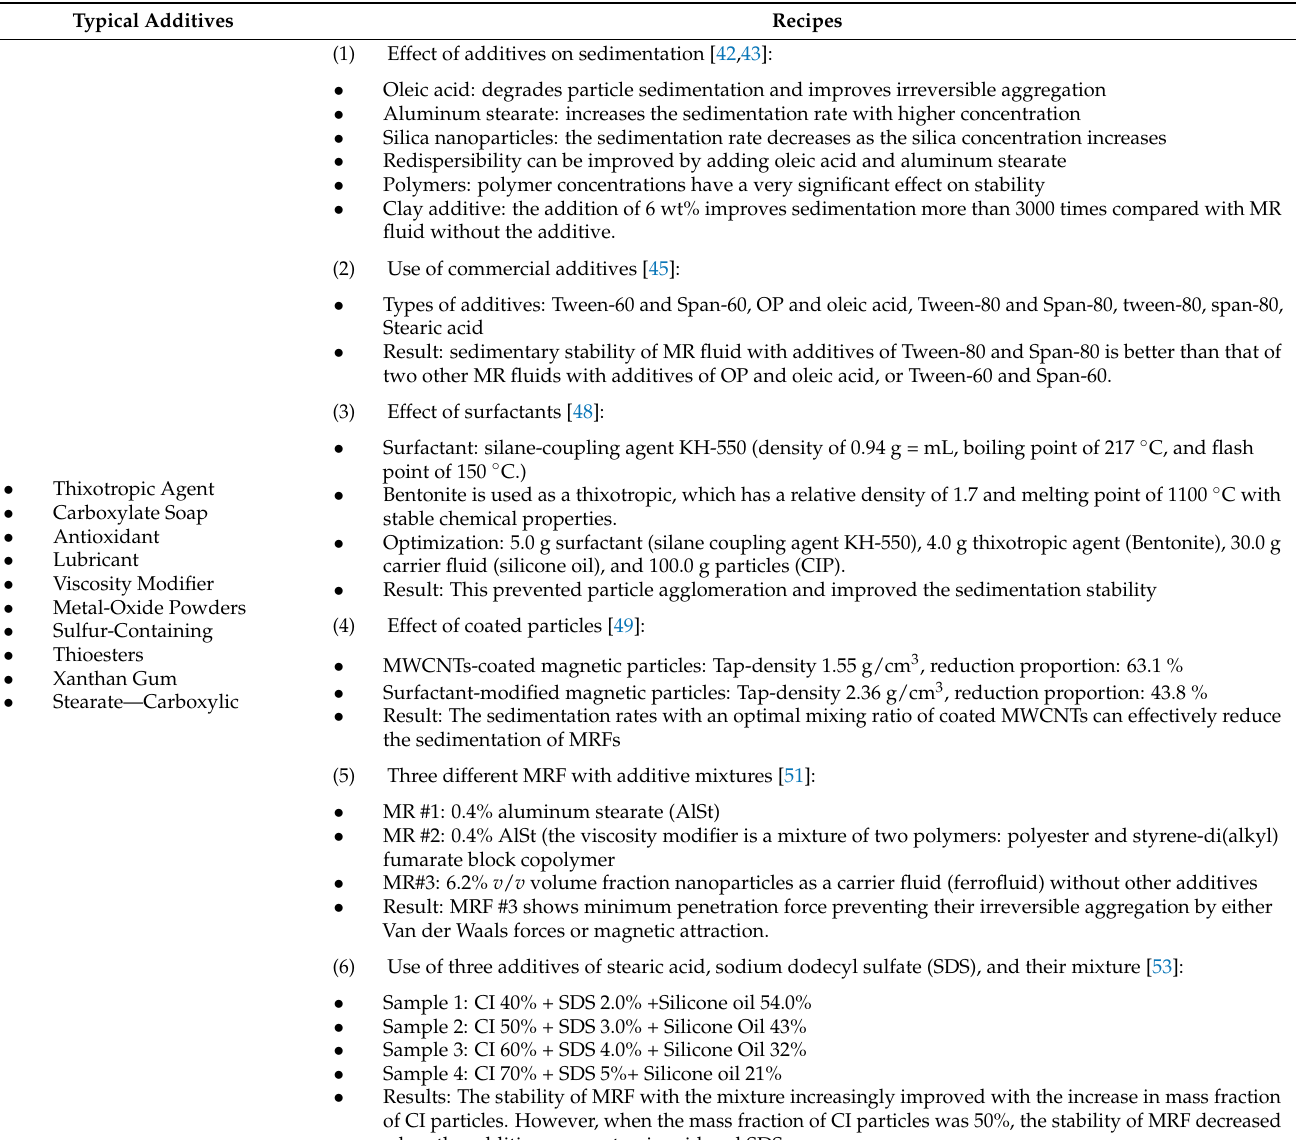
Table 3. Additives for Improvement of Sedimentation